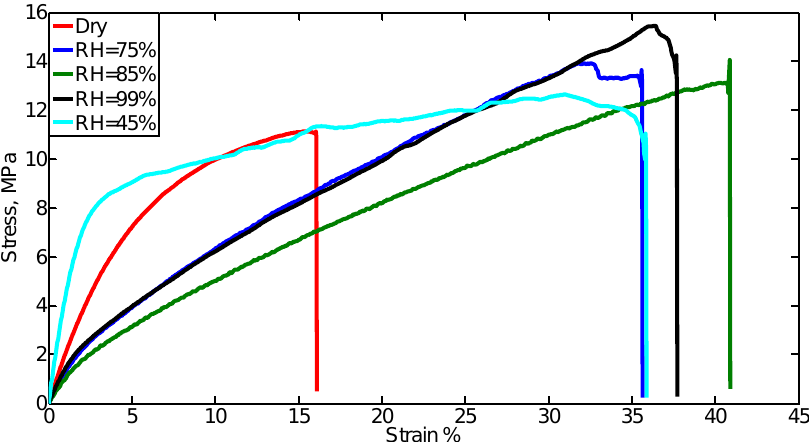
Figure 8. Stress–strain curve for spider silk (SS) nanofibers at different relative humidity (RH) values. A clear change in the strain range and ultimate stress is observed at all high-level humidity, compared to the case of the dry spider silk nanofiber mat. Table 2. Comparison of mechanical properties of SS nanofibers in different RH conditions. Mechanical Properties